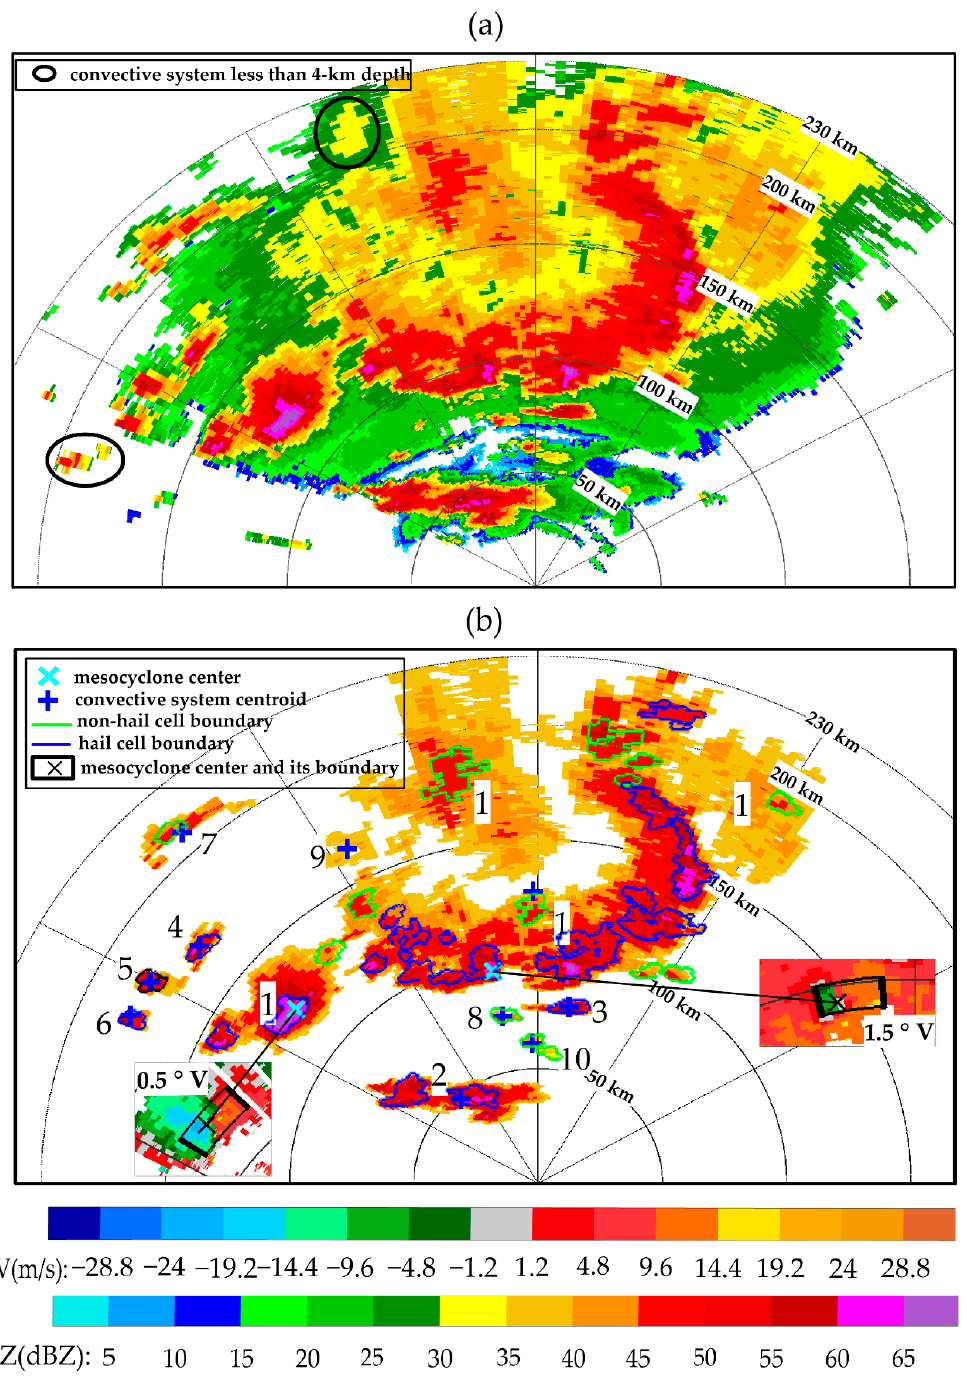
Figure 4. Illustration of differences in the identification results from the original SCIT and the modified SCIT at 2130 LST on 26 April 2019. ( a ) The real composite reflectivity; the shallow reflectivity echoes inside these black ovals were discarded by the above two algorithms. In ( b ), the spatially continuous and interconnected pixel regions labeled from “1” to “10” represent the composite reflectivity areas of the 10 non-adjacent convective systems identified by the modified SCIT, while the green and blue outlines inside the 10 convective systems indicate the boundaries of non-hail cells and hail cells identified by the original SCIT, respectively. The two small Doppler velocity figures show the areas (denoted by black rectangles) and center positions (denoted by black crosses) of the two mesocyclones in Convective System 1.